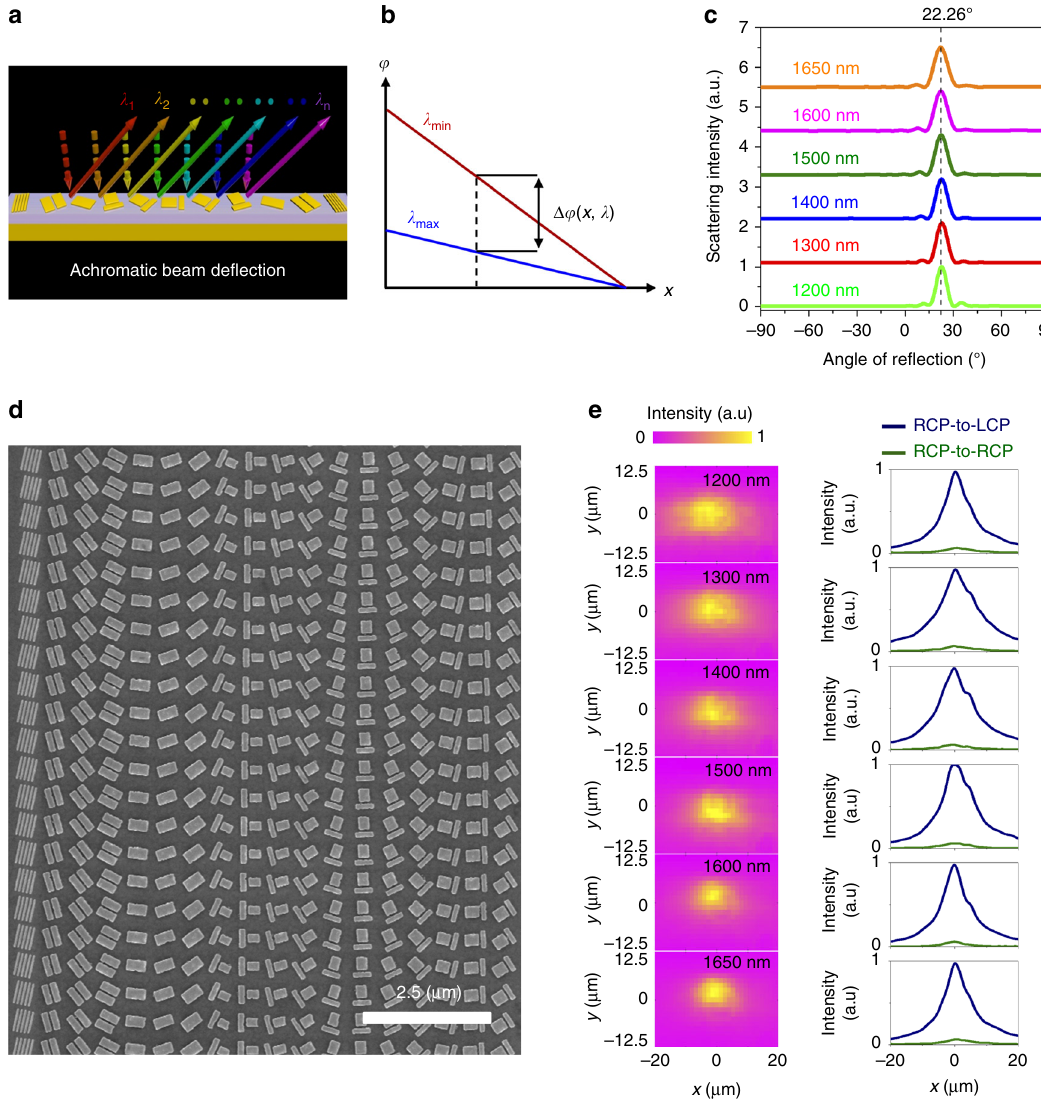
Fig. 5 Broadband achromatic gradient metasurfaces. a Schematic of beam de fl ection with BAGMS. All anomalously de fl ected angles are the same when the incident wavelength is changed. b Phase distribution for a BAGMS at different incident wavelengths. The Δ φ ( x , λ ) represents the phase difference between λ min and λ max at certain surface position. c Simulated intensity of RCP-to-LCP scattering light vs. angle of re fl ection at various incident wavelengths. The angle of re fl ection keeps at around 22.26 ˚ when the incident wavelength is changed from 1200 to 1650 nm. d SEM image of fabricated BAGMS. e ( Left ) Experimentally captured CCD images of RCP-to-LCP scattering light from the BAGMS. The intensities are normalized by the maximum value in each image. ( Right ) Cross section of normalized scattering light intensity along the central line of each corresponding CCD image for RCP-to-LCP ( navy curves ) and RCP-to-RCP ( olive curves )